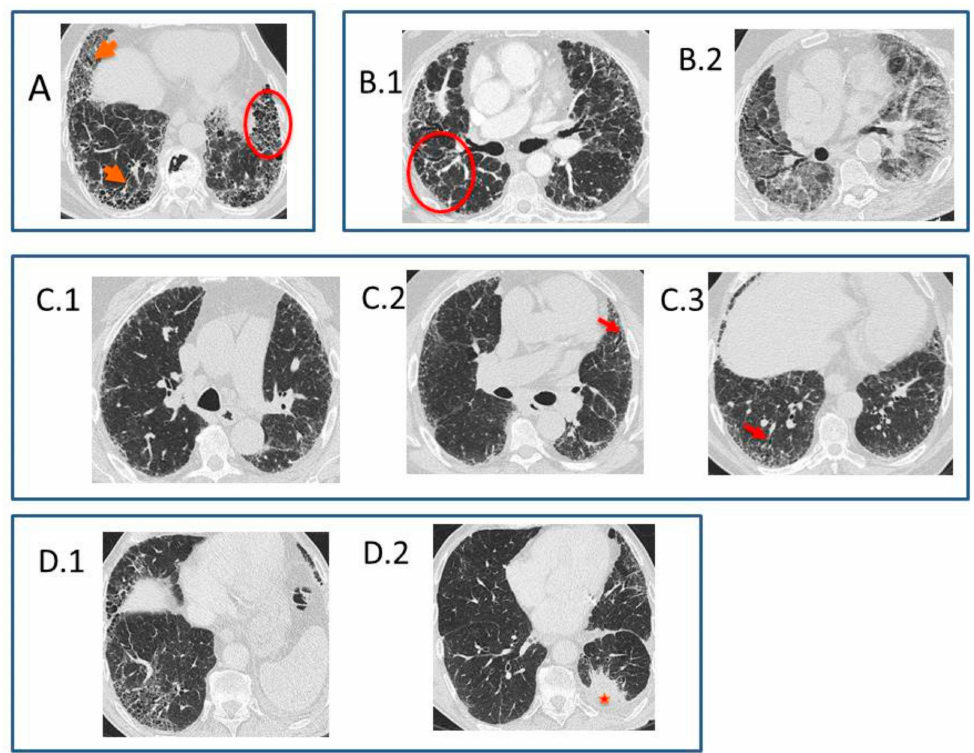
Figure 2. HRCT in IPF. ( A ) Typical UIP CT pattern. HRCT image: honeycombing (circle) and reticular opacities with peripheral traction bronchiectasis (arrows), with peripheral subpleural and basal-predominant distribution. ( B ) CT pattern indeterminate for UIP and acute exacerbation. ( B.1 ) HRCT image: reticular abnormalities with traction bronchiectasis and non-basal predominance (circle). ( B.2 ) HRCT image in left decubitus lateral six months after the previous examination: multifocal areas of ground glass opacities, overlapped with the previous pattern of pulmonary fibrosis. ( C ) Probable UIP CT pattern. ( C.1 – 3 ) HRCT images: reticular pattern with traction bronchiectasis (arrows in C.2 and C.3 ) and a peripheral subpleural and basal predominance; peripheral reticulation is non-segmental (crossing fissures), heterogeneous, and present in upper lobes. Note that there is no honeycombing, and the UIP histological pattern was proven with pulmonary biopsy. ( D ) IPF and lung adenocarcinoma. ( A , D.1 ) HRCT images: typical UIP CT asymmetrical pattern and lung mass in the apical segment of the left lower lobe (star in D.2